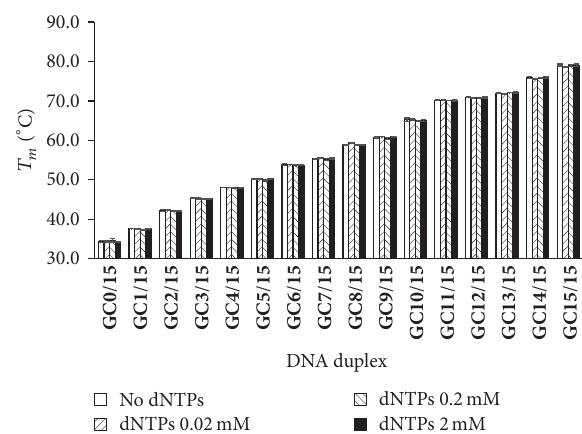
Figure 5: Effect of dNTPs on 𝑇 𝑚 measurement of DNA duplexes by HRM. The buffer contains 1x EvaGreen, 10 mM phosphate buffer (pH 7.4), and 100 mM NaCl. In this assay, 0, 0.02, 0.2, or 2mM dNTPs were